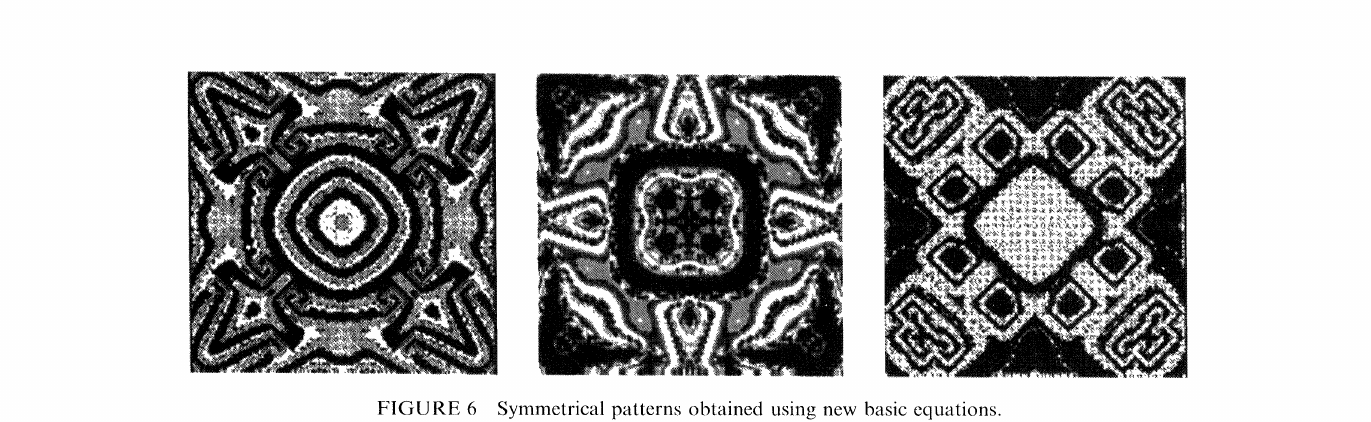
FIGURE 6 Symmetrical patterns obtained using new basic